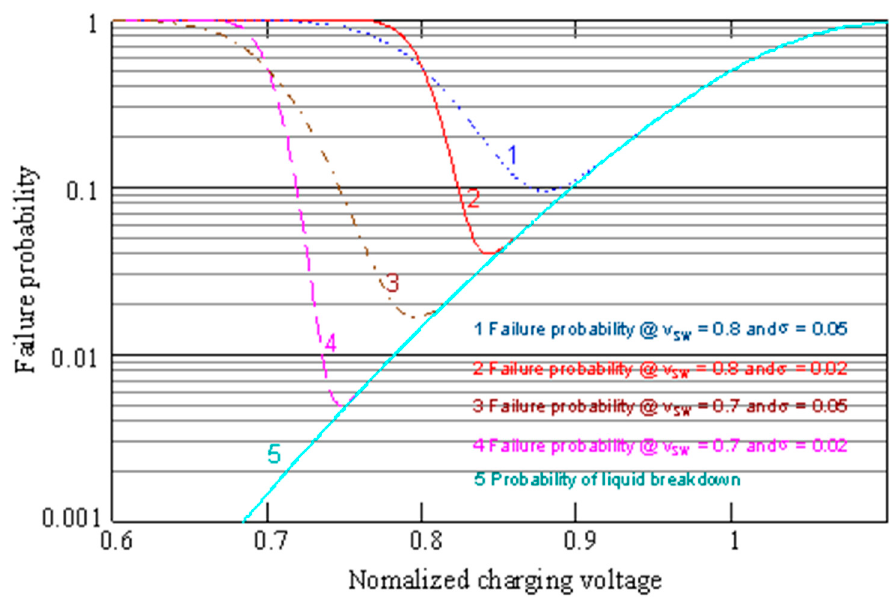
Figure 5. Failure probability of the forming line with switch voltage scattering considered.